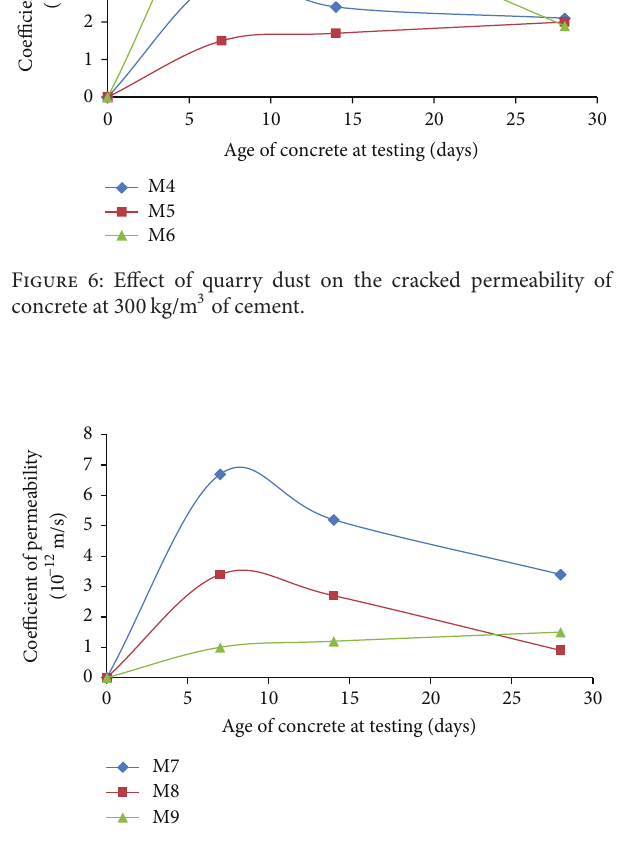
Figure 7: Effect of river sand on the cracked permeability of concrete at 350 kg/m 3 of cement.